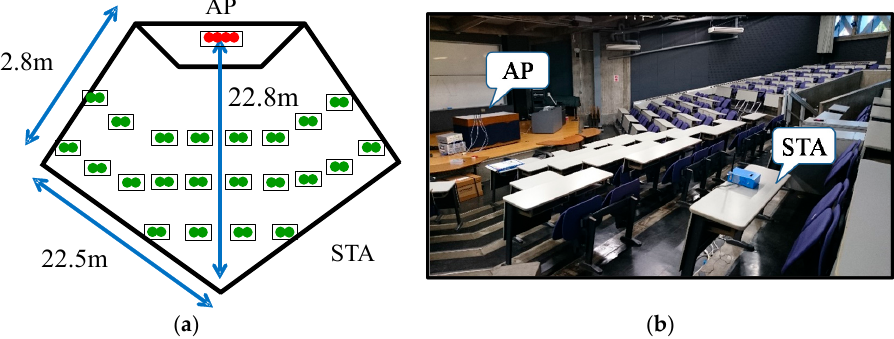
Figure 4. Experimental environments. ( a ) Room layout; and ( b ) photograph of room. Table 1. Experimental conditions.